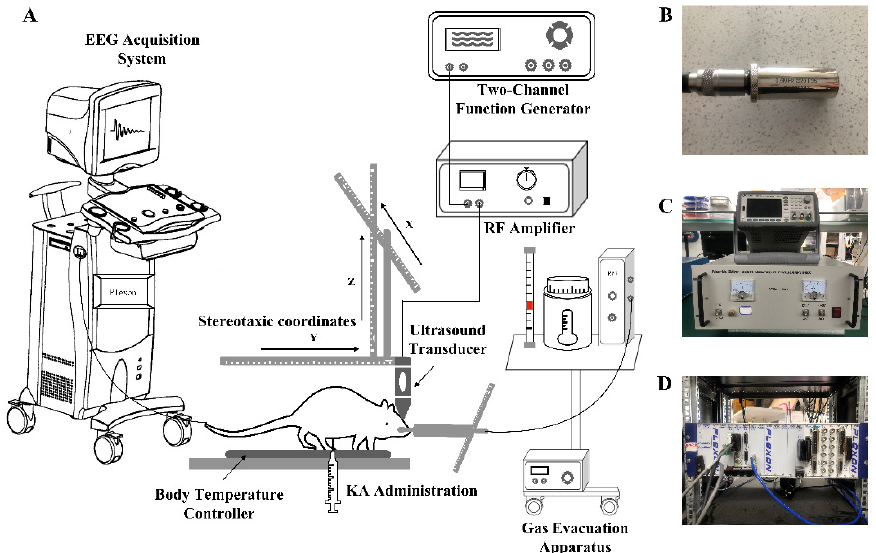
Figure 3. Basic ultrasonic brain stimulation rig. ( A ) Schematic view of the experimental apparatus. ( B ) Shown is a focused ultrasound transducer with a 0.5 MHz center frequency. ( C ) Top, a two- channel waveform generator used to trigger ultrasound pulses. Bottom, an RF amplifier used to receive an input voltage waveform to provide the output power to the transducer for producing the acoustic pressure profile of an LIFU stimulus waveform. ( D ) Shown is the signal acquisition device.